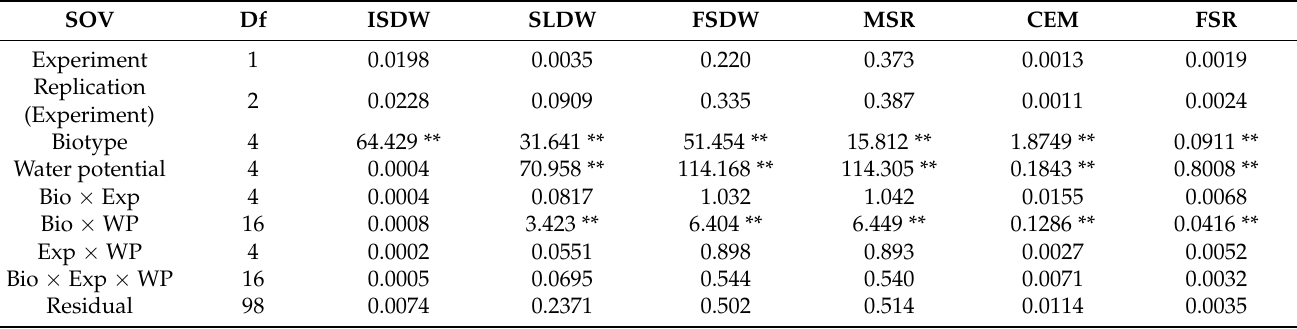
Table 5. Results of analysis of variance (mean squares) for initial seed dry weight (ISDW), seed remnants dry weight (FSDW), seedling dry weight (SLDW), the weight of mobilized seed reserve (MSR), the conversion efficiency of mobilized (CEM), and the fraction of seed reserve (FSR).